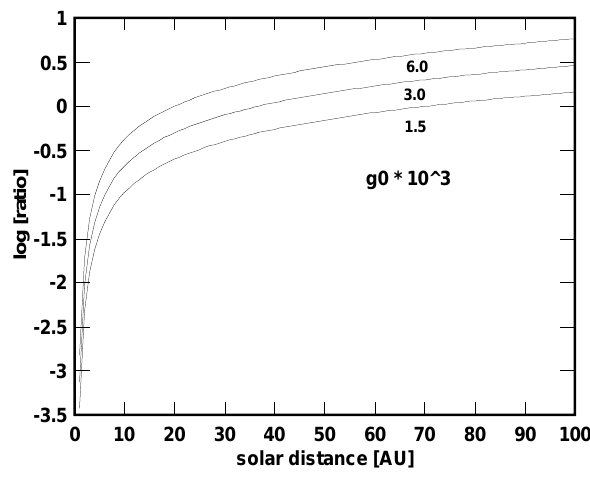
Fig. 1. Shown is the ratio R i/b = Q i 1 /Q b 1 as a function of the solar distance in units of AU for various values of g 0 = 1 . 5 ; 3 . 0 ; 6 . 0 · 10 − 3 . The other relevant parameters in the calculations hereby are taken to be equal to G 0 = 0 . 1 and s = 9 /